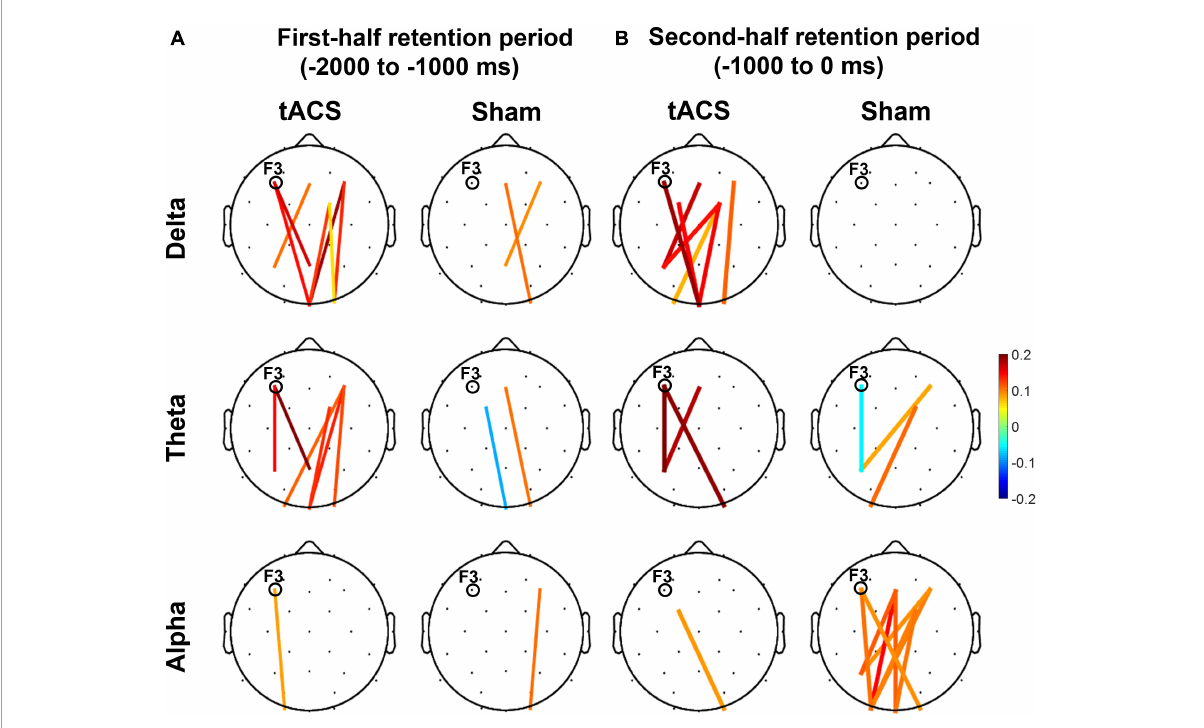
FIGURE6 Topographical changes in pairwise phase consistency (PPC) between pre- and post-treatment in the delta, theta, and alpha bands. The color-coded lines in the grand-averaged topographies represent differences in PPC between pre- and post-treatment (post-treatment minus pre-treatment) during (A) the first half ( − 2,000 to − 1,000 ms before the test-stimulus presentation) and (B) the second half ( − 1,000 to 0 ms before the test-stimulus presentation) of the retention periods in both the tACS-treated and sham groups. The red lines indicate a significant enhancement of PPC connection strength, whereas the blue lines indicate a significant reduction of PPC connection strength. Only the statistically significant differences in PPC connections ( p < 0.05, FDR-corrected) between the frontal (Fz, F3, F4, FC1, and FC2) and parieto-occipital region (Pz, P3, P4, Oz, O1, and O2) are displayed in colored lines. The electrode position for tAC stimulation (i.e., F3) is marked in each topography. The view of the topography is from the vertex, with the nose at the top of the